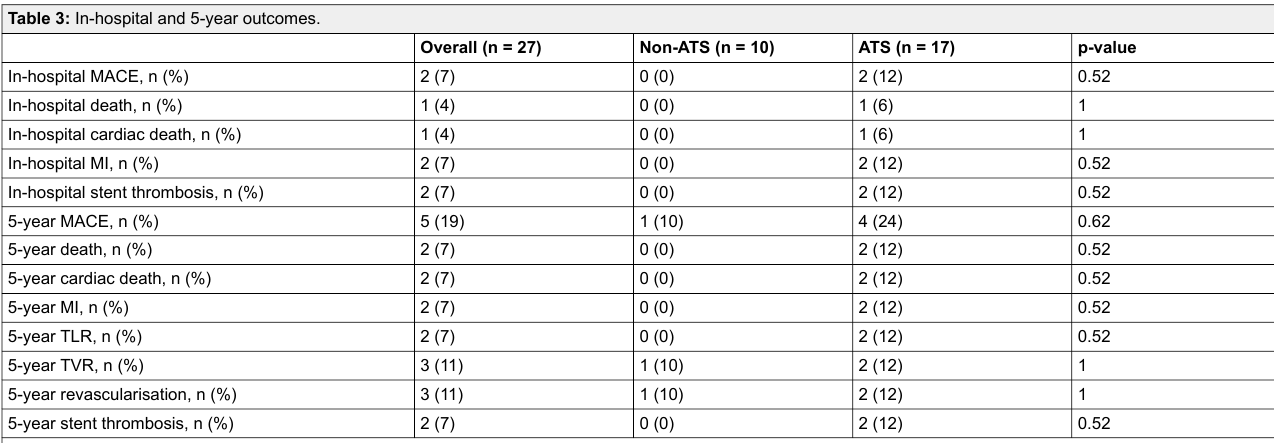
Table 3: In-hospital and 5-year